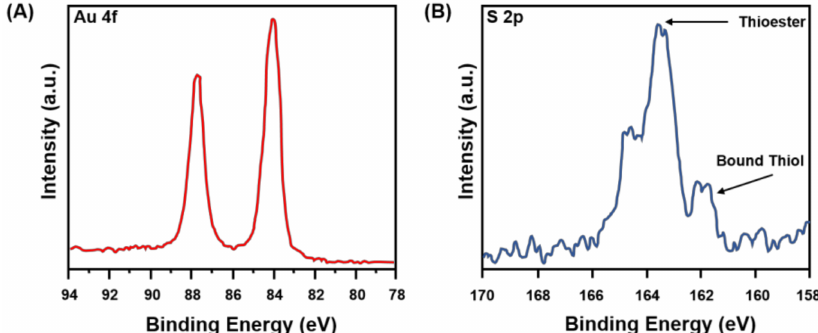
Figure 2. XPS spectra for HSPEG2000 -functionalized nanoshells for ( A ) the Au 4f region and ( B ) the S 2p